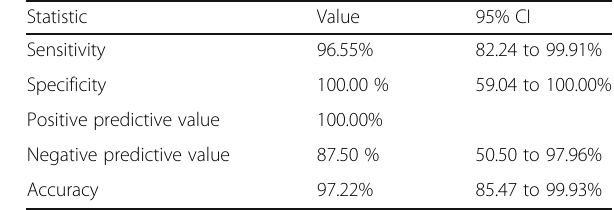
Table 5 Demonstrating the accuracy measures